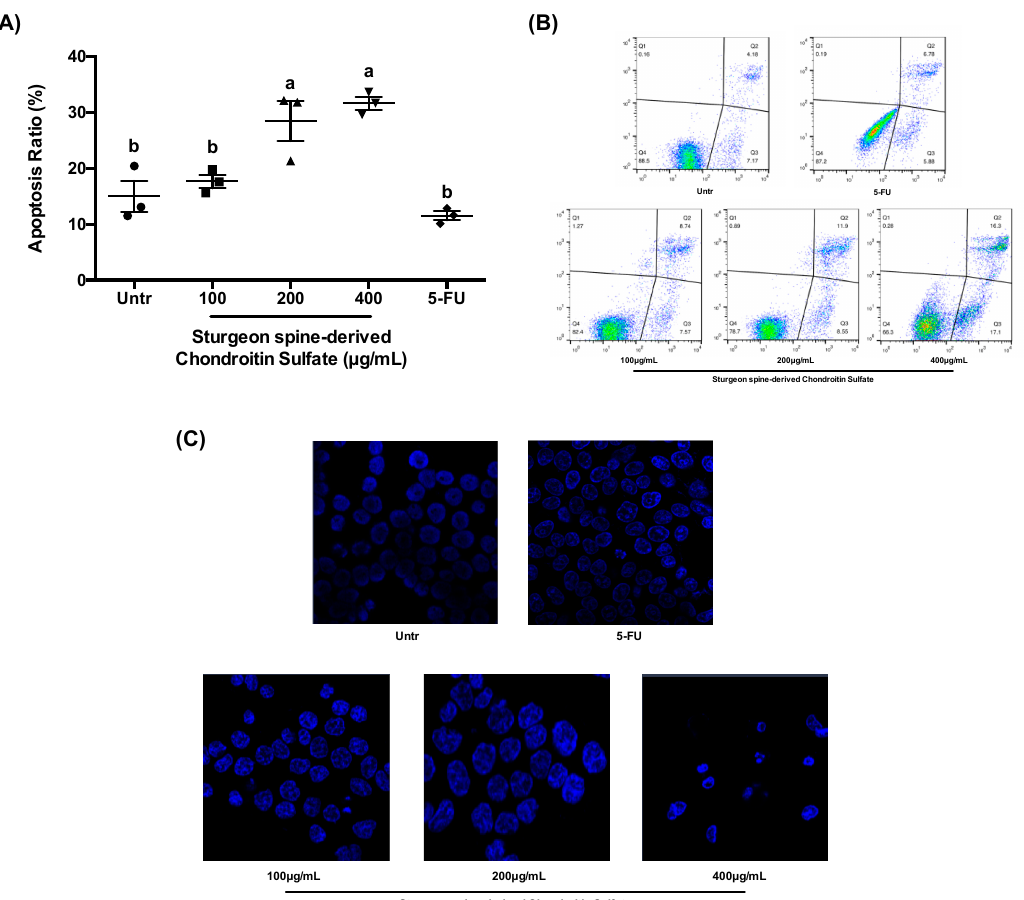
Figure 3. Effect of SCS on cell apoptosis in colon cancer HCT-116 cells. Colon cancer HCT-116 cells were treated with different concentration (100, 200, and 400 μ g/mL) of SCS (spine) and 5-FU (100 μ g/mL) for 24 h. The apoptosis ratios (%) were calculated by cell apoptosis assay kit and flow cytometer, and the apoptotic bodies were identified by immunofluorescence microscopy. ( A ) Apoptosis ratio, ( B ) representation flow cytometer images, ( C ) representation images of apoptotic bodies. All results are expressed as mean ± SEM ( n = 3). Different superscript letters for each column indicate significant differences ( p < 0.05) as compared to every other group.